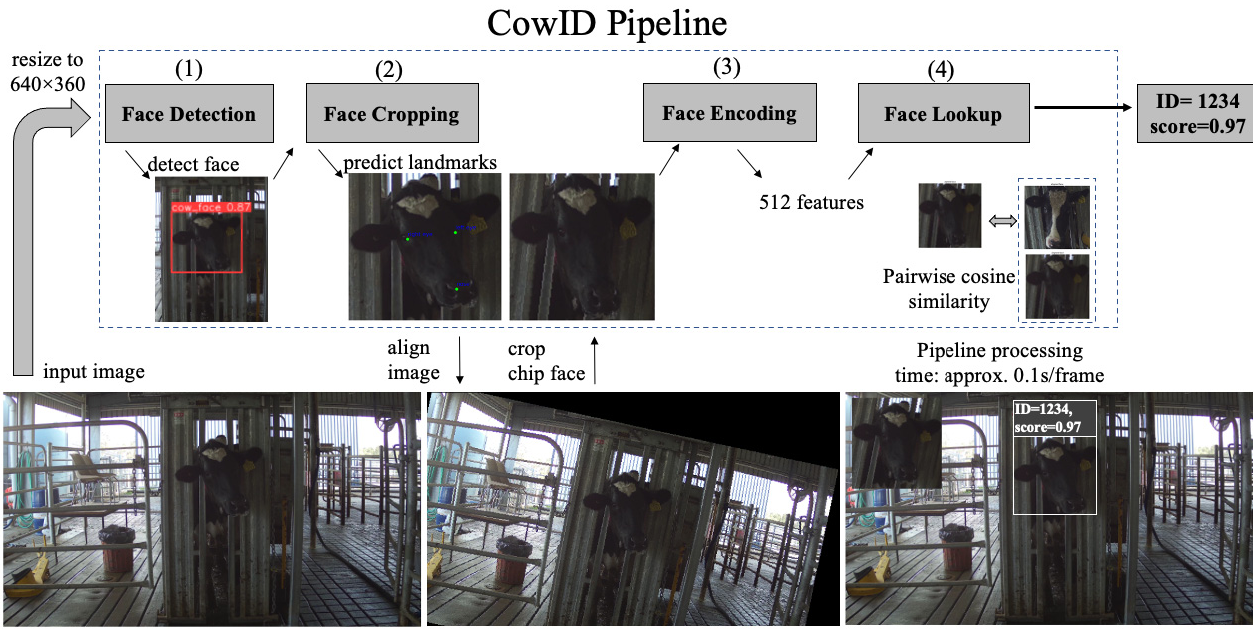
Figure 2. Diagram showing the pipeline of the cows recognition and identification system.